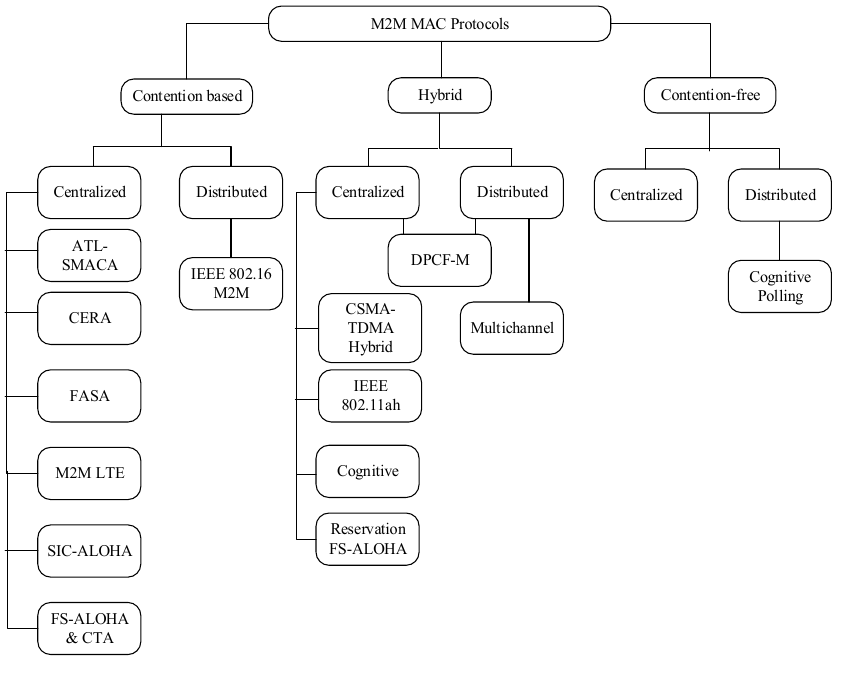
Figure 1. MAC layer M2M protocols.